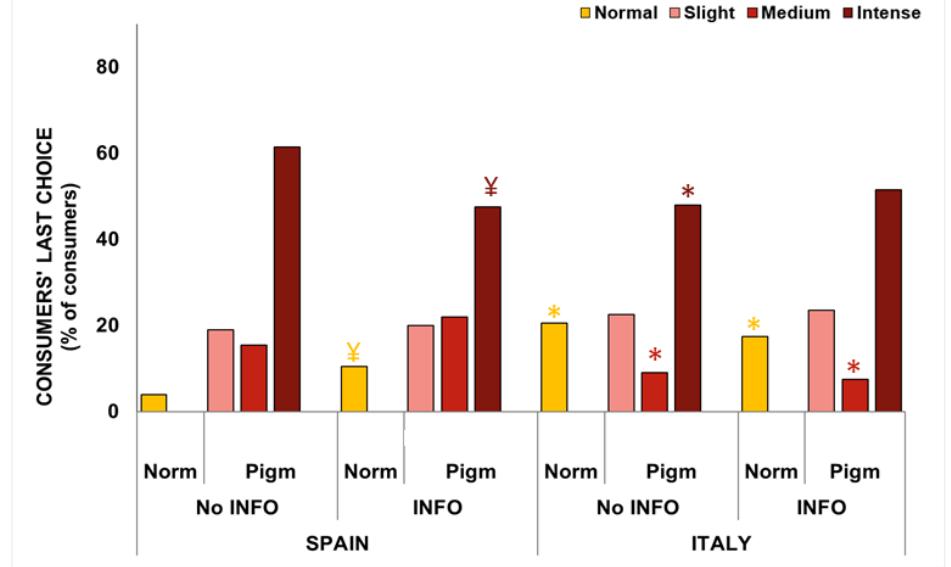
Figure 3. Percentage of consumers from Spain and Italy who indicated each mandarin type (normal-, slight-, medium- and intense-pigmented varieties) as their last choice. The Informed consumers (Info) received information about the antioxidant properties of the pigmented mandarins. ¥ indicates significant differences between the percentage of informed and uninformed participants in each of the countries who selected a specific type of mandarin. * indicates significant differences between the percentage of Italians and Spaniards who selected a specific type of mandarin under the same condition of information.